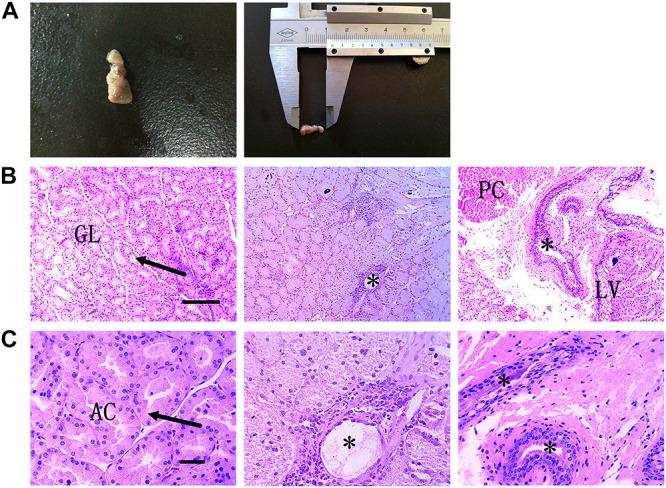
External anatomical structure and histological structure of HG in hamsters. (A) Morphological structure of HG. (B) Plasma cells and secretory ducts in HG are shown under low-power magnification. Scale bar = 100 μm. (C) Plasma cells and secretory ducts in HG are shown under high-power magnification. Scale bar = 20 μm. Arrow, acinar cell; asterisk, secretory duct; PC, plasma cells; LV, lipid vacuolation; GL, gland leaflet; AC, acinar cavity.